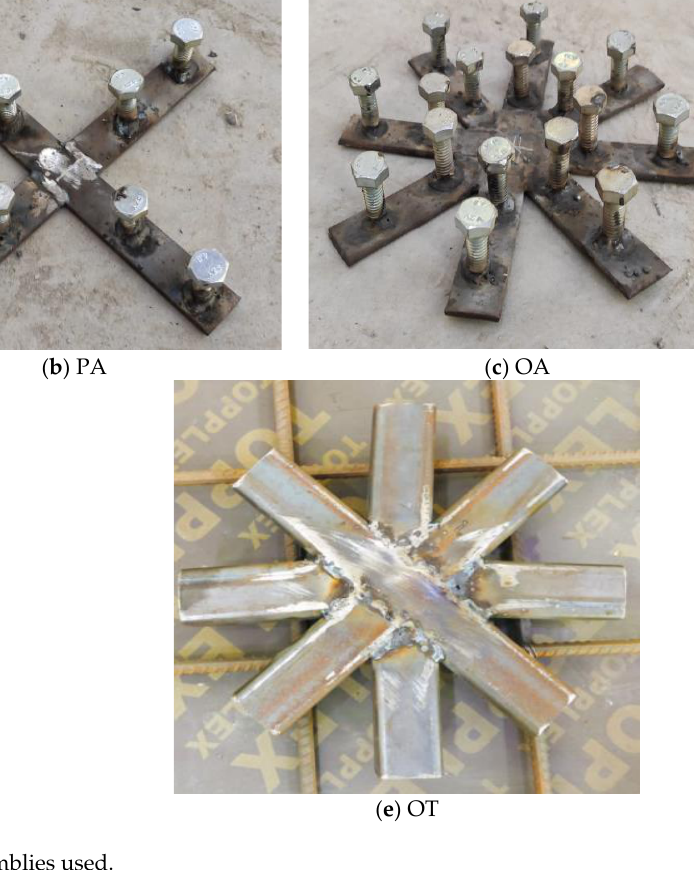
Figure 1. The steel assemblies used .